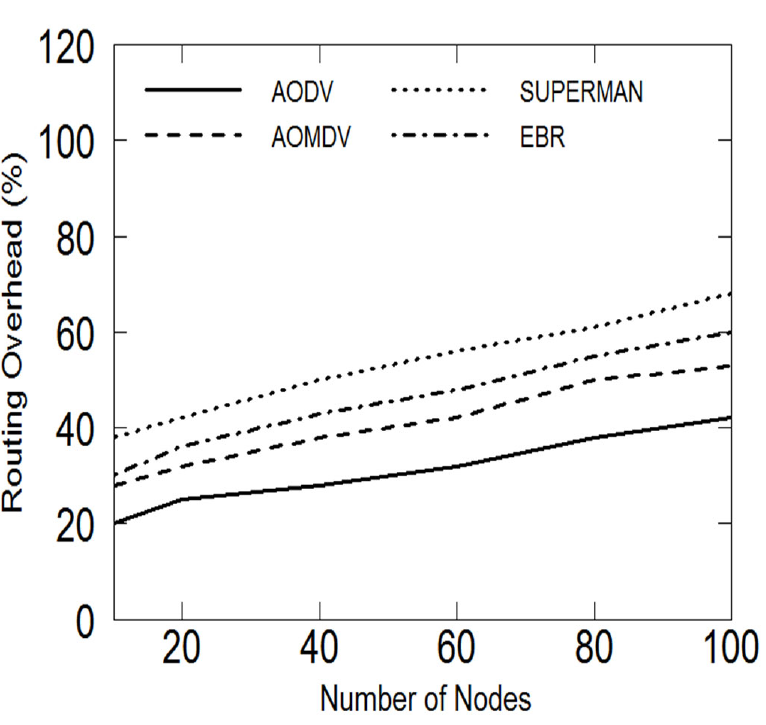
Figure 16. Routing overhead vs. number of nodes (with attack).